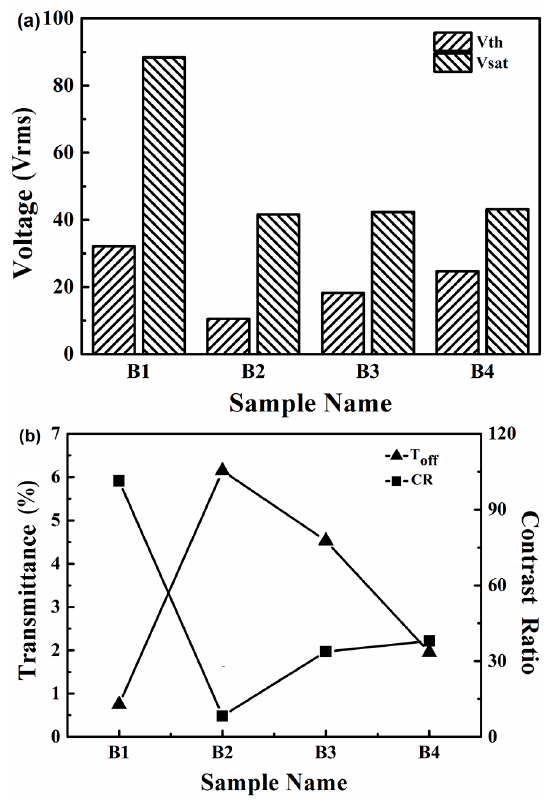
Figure 6. ( a ) Vth and Vsat of samples B1–B4; ( b ) Toff and CR of samples B1–B4.